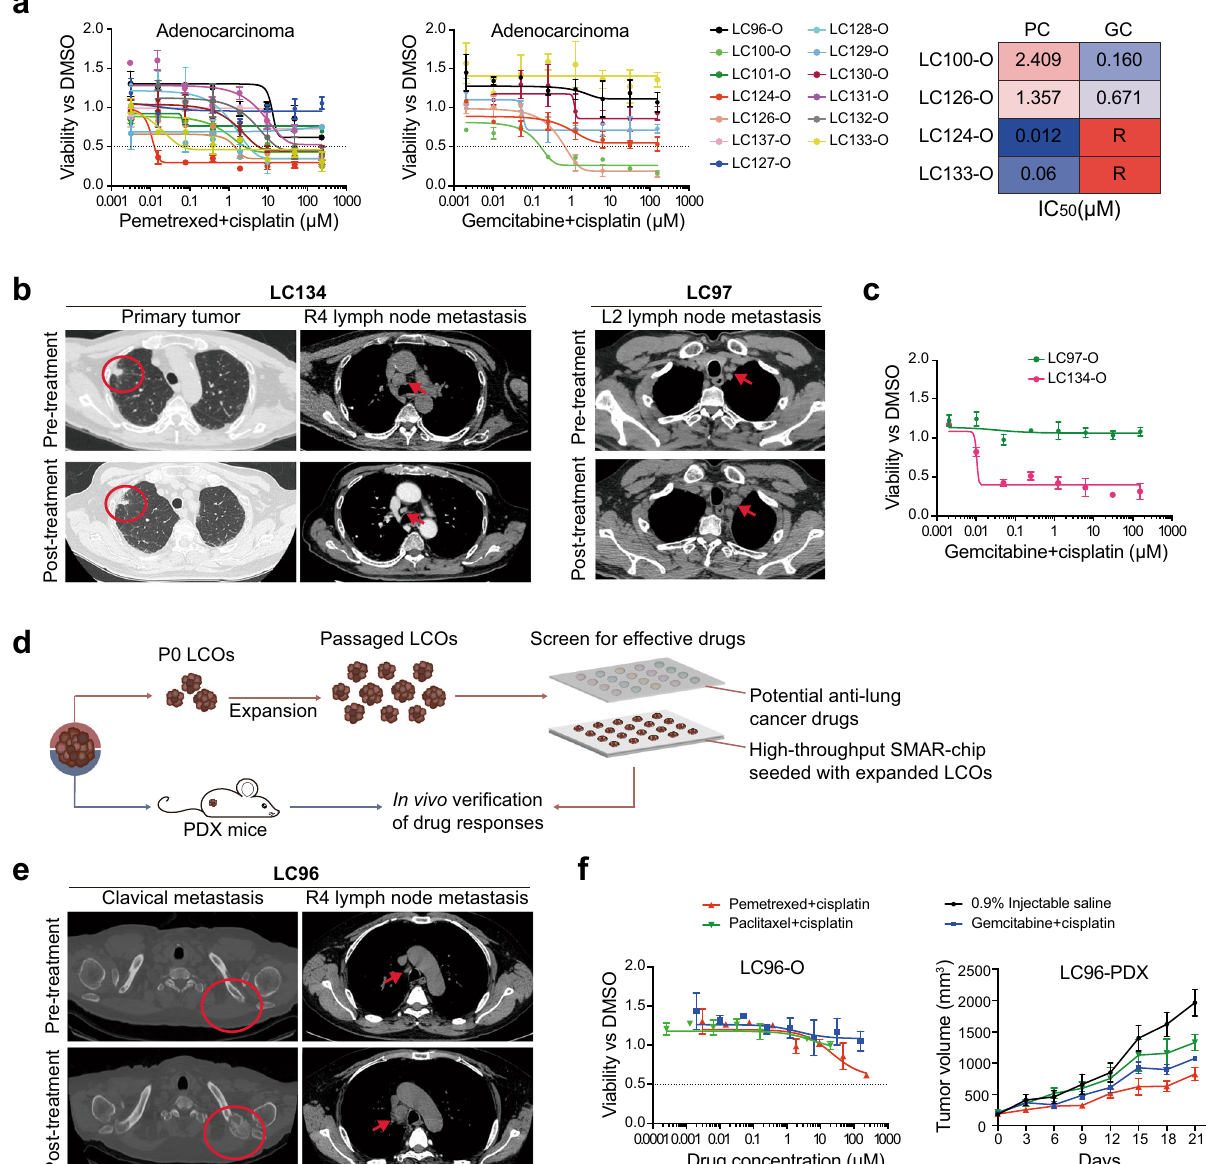
Fig. 6 One-week drug sensitivity tests represent the response heterogeneity of tumors to chemotherapies. a Heterogeneous responses of organoids derived from lung adenocarcinomas to the cisplatin-based chemotherapies. The fi tted dose – response curves illustrate the responses of the AC organoids to pemetrexed + cisplatin (PC) and gemcitabin + cisplatin (GC) ( n = 3 biologically independent cells, data are presented as mean ± SD). The heat map on the right are examples of two organoids sensitive to PC and the other two sensitive to GC. R means the IC 50 is not available. b LCO-based on-chip drug sensitivity tests representing the responses of patient tumors to chemotherapies. The CT images on the left are a lung squamous cell carcinoma sensitive to the GC therapy. The red circles indicate the primary tumor and the red arrows point to the metastatic lymph nodes, both of which shrank upon the GC treatment. The CT scan images on the right showed a lung squamous cell carcinoma resists the GC therapy. The red arrows point to the station L2 lymph nodes where new metastasis was discovered after two cycles of adjuvant chemotherapy with GC. c Fitted the dose – response curves of the LCOs representing the diverse responses of the in vivo tumors to the chemotherapy ( n = 3 biologically independent cells, data are presented as mean ± SD). d LCO-based on-chip screening of anticancer drugs effective to individual patients. e On-chip drug screening using the organoid line (LC96-O). The CT scan images showed the patient tumor metastasized to bone (red circles) and lymph node (red arrows) during chemotherapy with PC. f Drug – response curves on the left showing the results of the on-chip screening of three chemotherapies (PC, GC, and paclitaxel + cisplatin) using the LC96-O. The line charts on the right represent the tumor volume of the PDX exposed to the same chemotherapies as the LCOs. Both of the results consistently showed that none of the drug combinations could inhibit the growth of the tumor effectively ( n = 3 biologically independent LCOs in the left panel; n = 4 biologically independent animals in the right panel, data are presented as mean ±